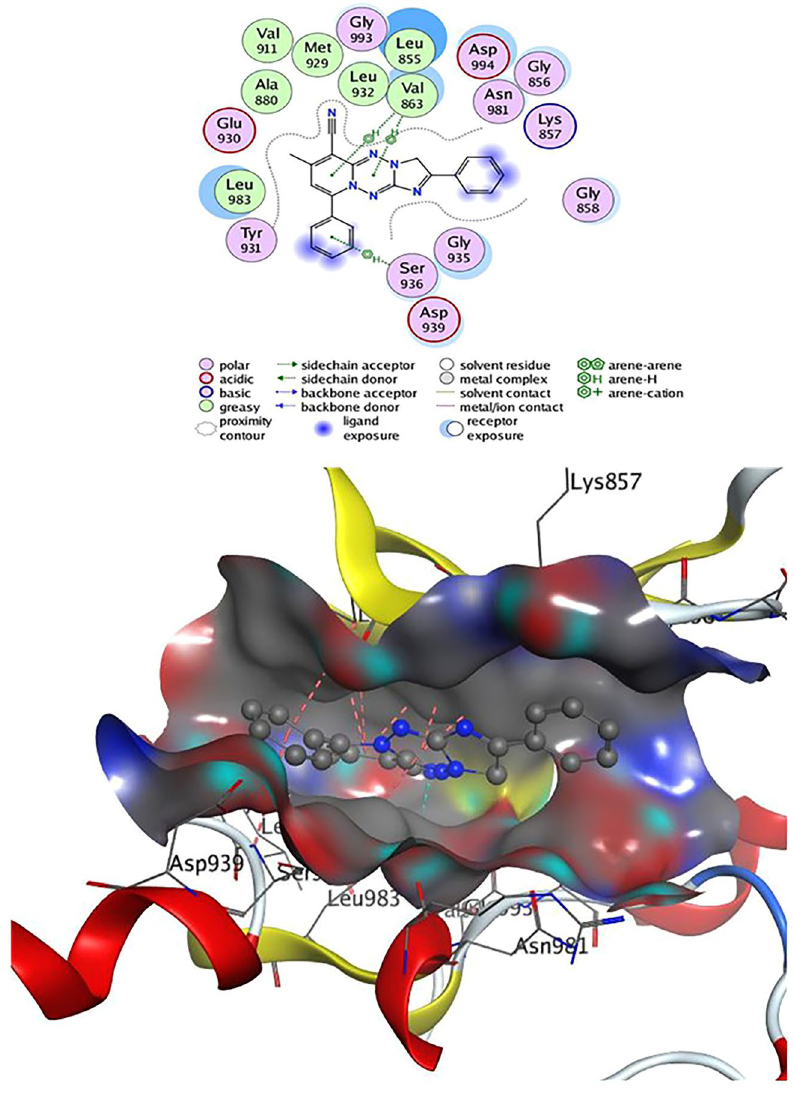
Figure 9. 2D& 3D interaction of 9 in the active site of Janus kinase Jak2 (PDB ID: 4P7E ). Hydrogen bonds are displayed in cyan & H-pi-bonds are in dark